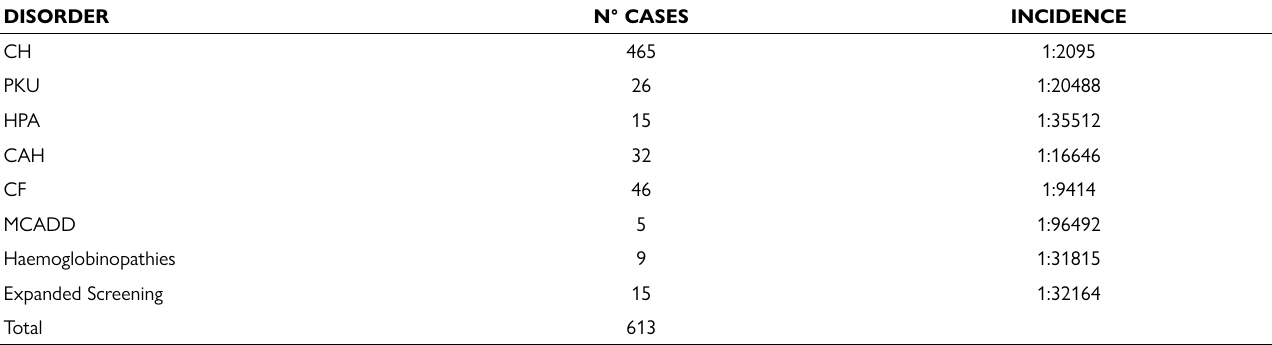
CH: Congenital hypothyroidism; PKU: Phenylketunuria; HPA: Hyperphenylalaninemia; CF: Cystic Fibrosis; MCADD: Medium-chain acyl-CoA dehydrogenase deficiency; CAH: Congenital adrenal hyperplasia. Table 3. Cases detected as false positives and the causes. Altered biomarker